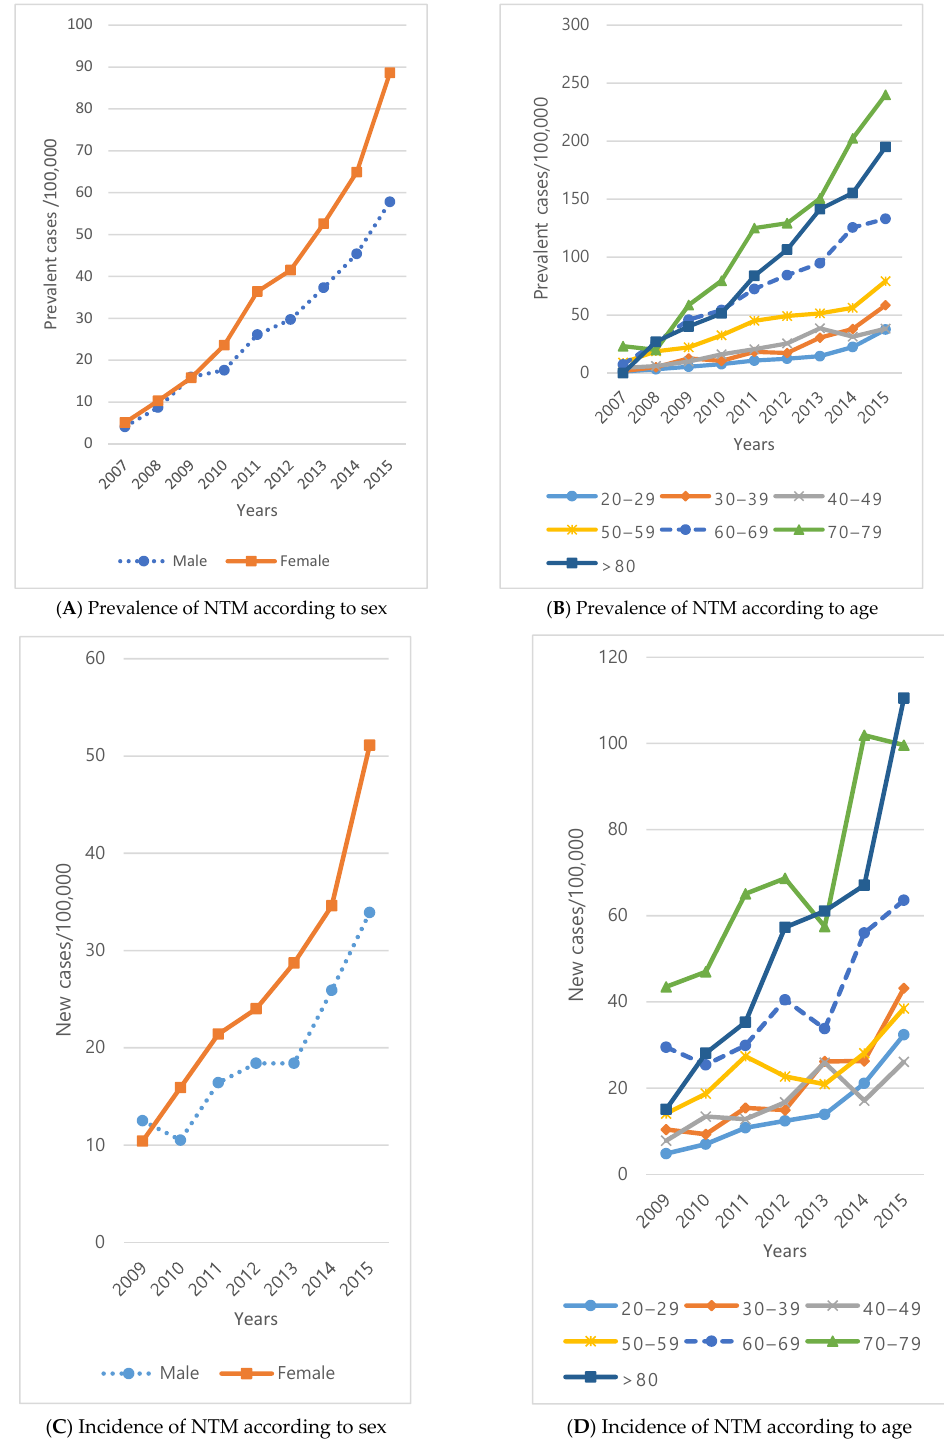
Figure 3. Temporal trends of NTM prevalence and incidence by sex and age.